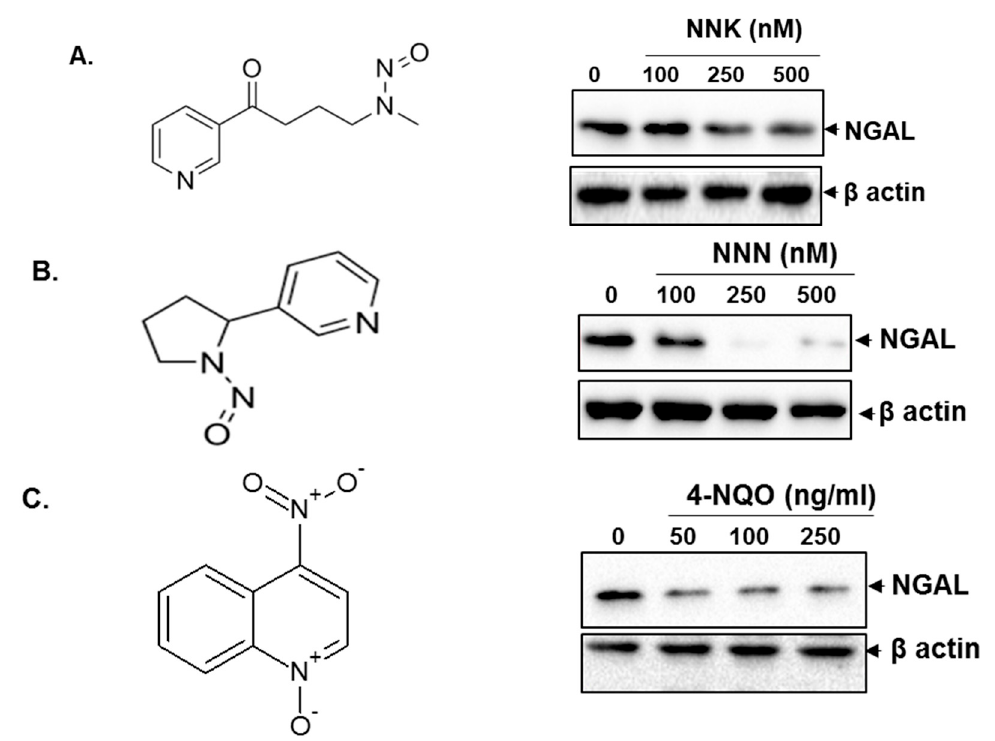
Figure 2. Tobacco components downregulated the expression of NGAL in oral cancer cell line SAS. ( A ) Structure of NNK (left panel). Western blot analysis of expression of NGAL after treatment with NNK for 48 h in SAS cells ( n = 2) (right panel). ( B ) Structure of NNN (left panel). Western blot analysis of expression of NGAL after treatment with NNN for 48 h in SAS cells ( n = 2) (right panel). ( C ) Structure of 4-NQO (left panel). Western blot analysis of expression of NGAL after treatment with 4-NQO for 48 h in SAS cells ( n = 2) (right panel).